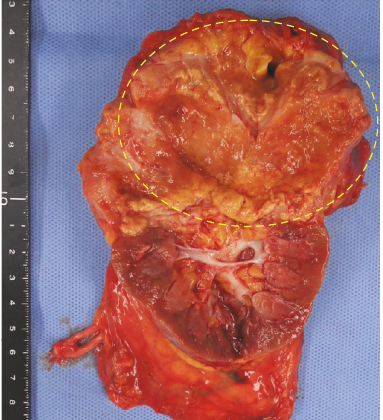
Figure 3: The resected specimens: a yellowish-white tumor in the upper renal parenchyma and incomplete double